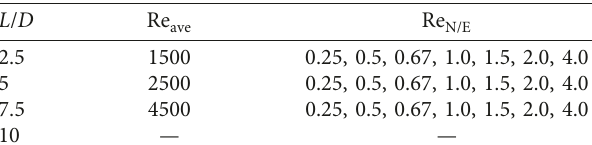
Table 4: Summary of the experimental cases at double-Tee junctions with varied Reynolds number ratio at outlets (Re � Re W/E